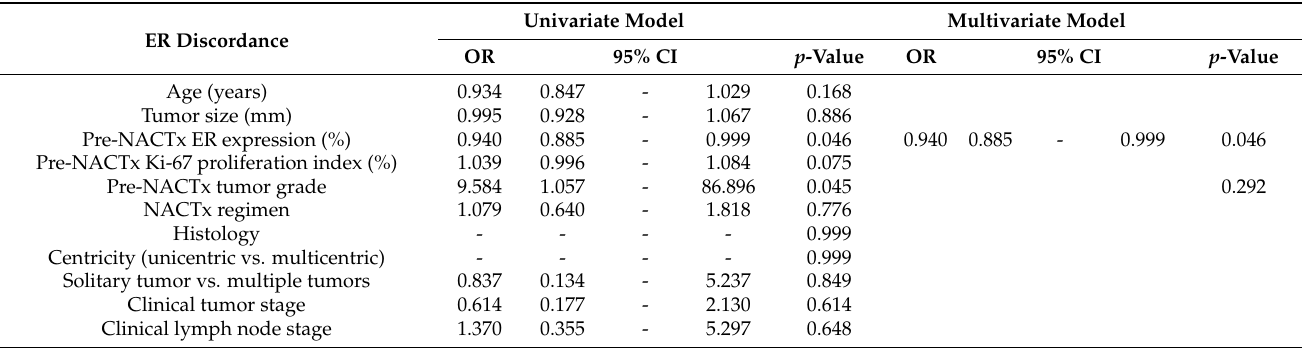
Table 3. Binary logistic regression analysis for ER